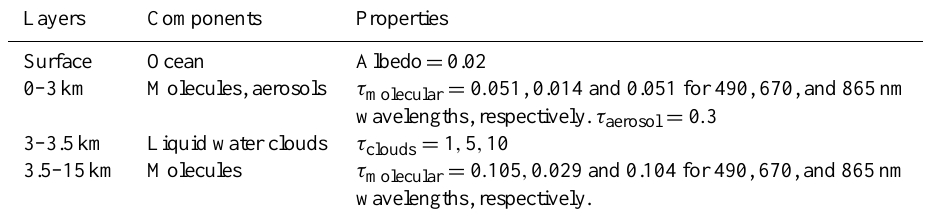
Table 1. The atmospheric layers and components assumed in the RT3 model for simulating the POLDER-like polarized signal. Lambertian surfaces are treated in the simulation with constant albedo value. The τ molecular and τ clouds represent the optical thickness of aerosol and cloud layers,